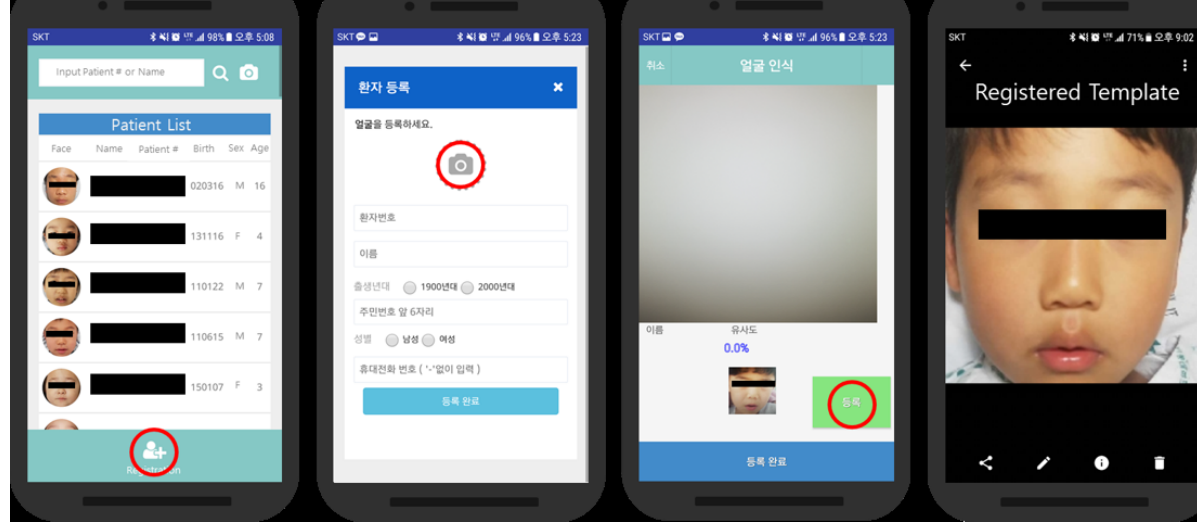
Figure 3. Facial recognition